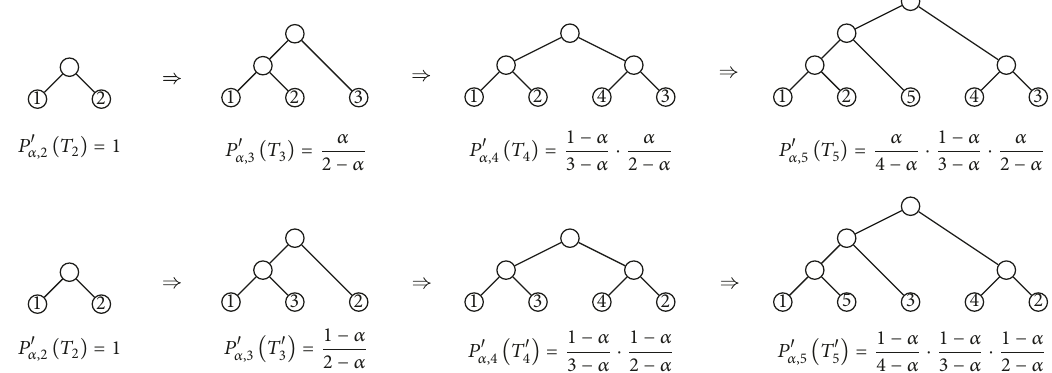
Figure 4: Two examples of computations of the probability 𝑃 󸀠 𝛼,𝑛 of a cladogram through its construction in Step (2) of the definition of the 𝛼 -model.